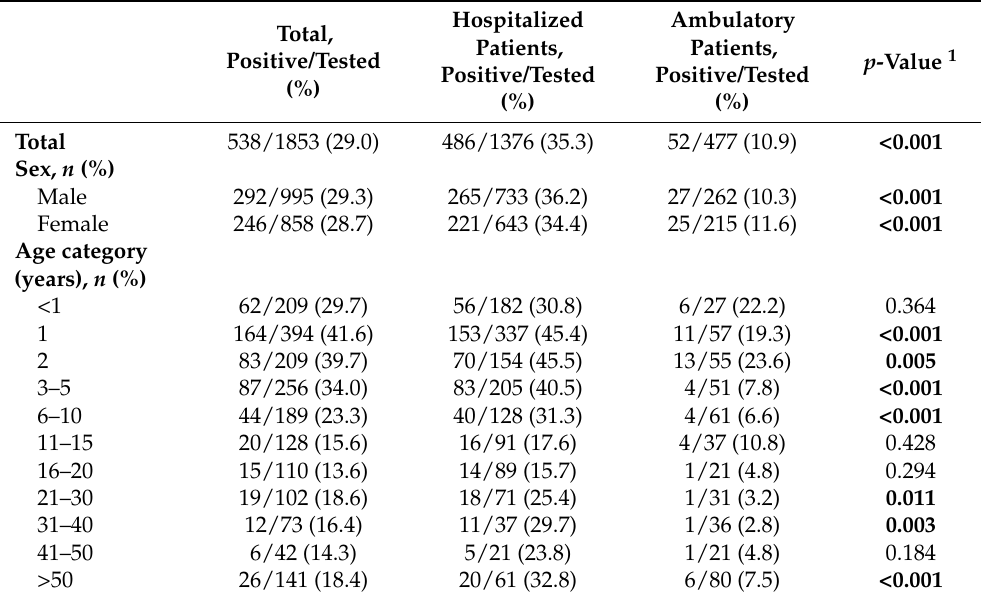
Table 1. Demographic characteristics of patients with RV-positive stool samples during the period 2012–2018 in Vojvodina province, Serbia, by hospitalization status.